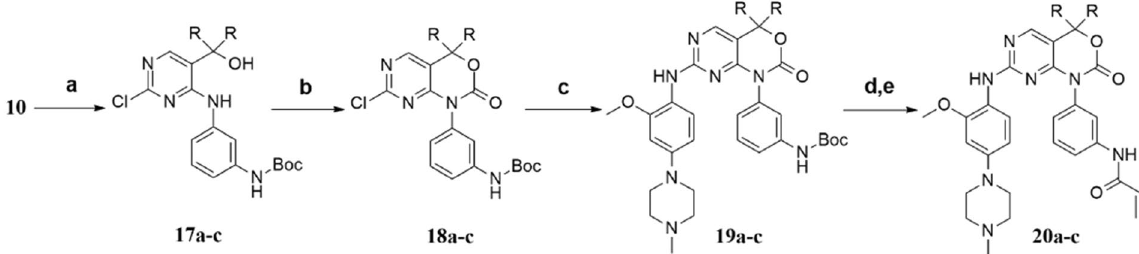
Figure 4. Synthesis of the target compounds 20a - c a . a Reagents and conditions: ( a ) RBrMg, dry THF, 0 °C, 8–10 h, 33–48%; ( b ) 1,1 ′ -carbonyldiimidazole, K 2 CO 3 , dry CH 3 CN, r.t., overnight, 65–85%; ( c ) arylamine, trifluoroacetic acid, isopropanol, reflux, overnight, 52–61%; ( d ) trifluoroacetic acid, CH 2 Cl 2 , r.t., 5 h, 78–83%;